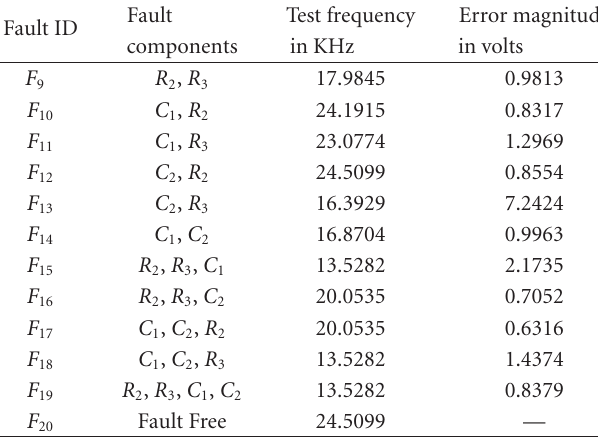
Table 2: Test frequencies for the multiple faults for test circuit.